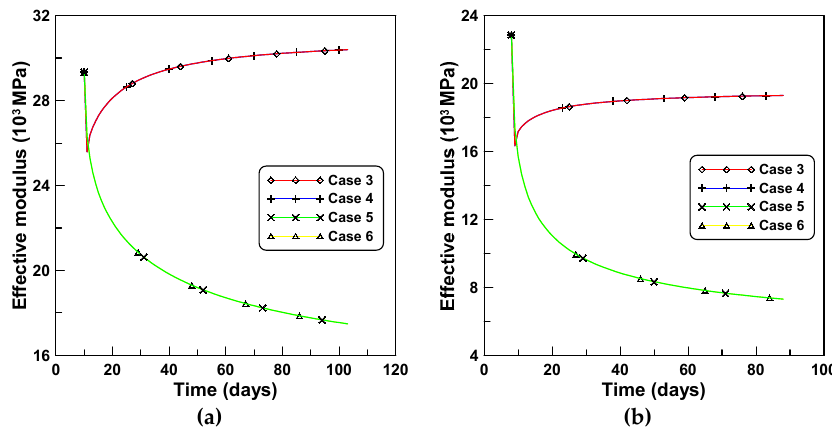
Figure 6. Variations of effective moduli of four creep models: ( a ) test series A and ( b ) test series B.